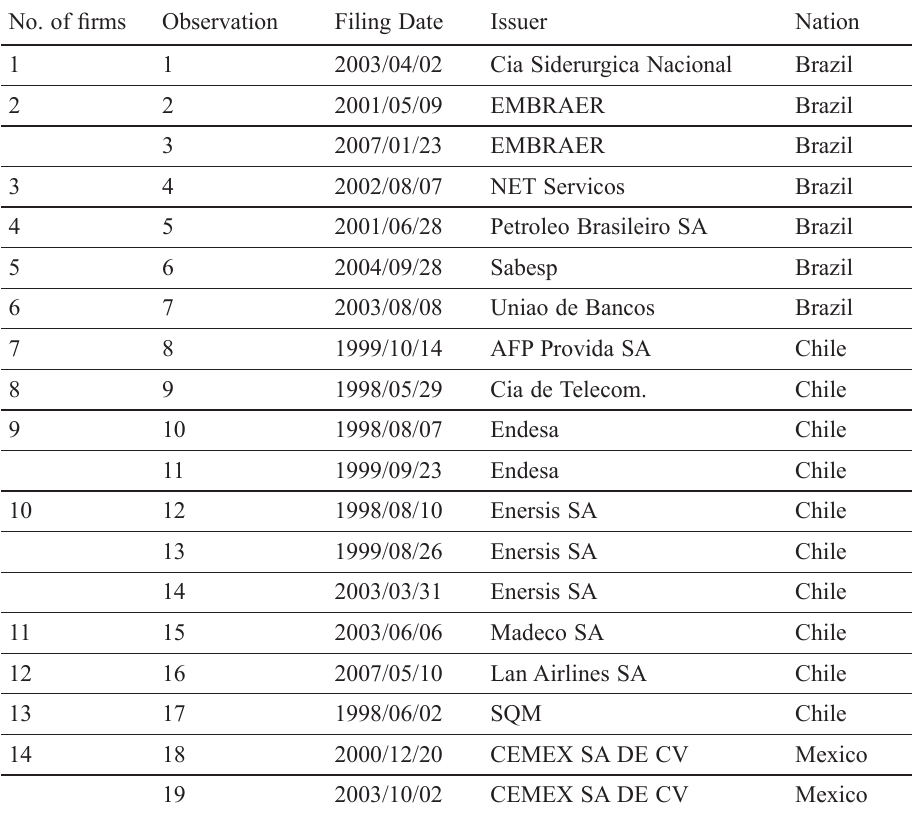
Table 2. Sample of emerging market stock SEOs issued over